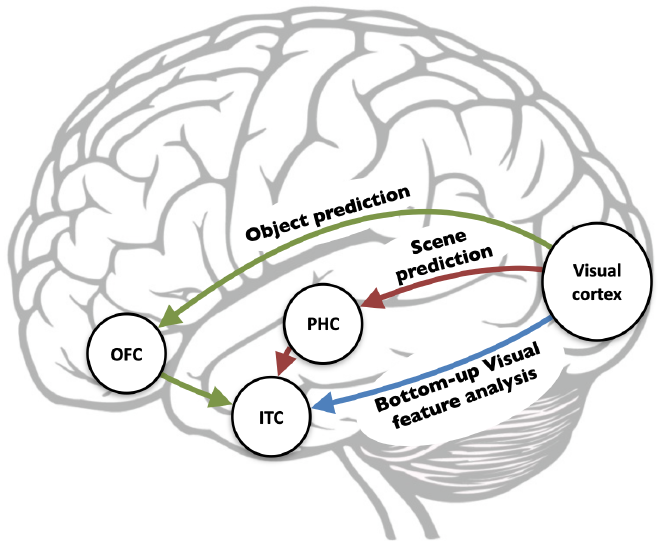
Figure 3. Top-level schematic illustration of the pathways in the Visual Associative Predictive (VAP)